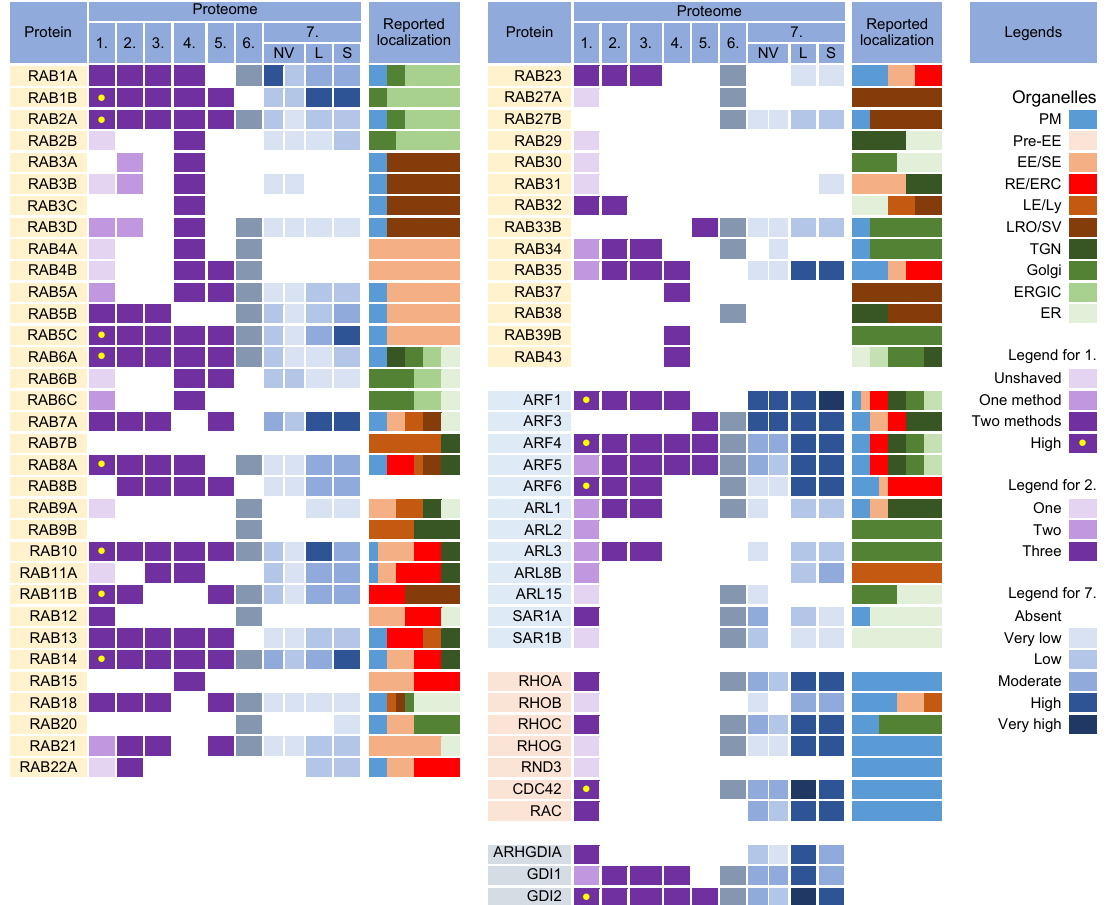
Figure 5. Membrane-trafficking-associated small GTPases in virion and extracellular nanoparti- cle preparations. Small GTPases were identified in proteomes of virion preparations (HCMV proteomes 1–5 and HSV-1 proteome 6), NVEPs (NV), l EVs (L), and s EVs (S) (proteome 7). The reported localization in membrane organelles of non-infected cells is shown by a color code to il- lustrate the preferred localization [49,59,60,69,95–130]. Proteomes used for analysis and legends are described in Figure